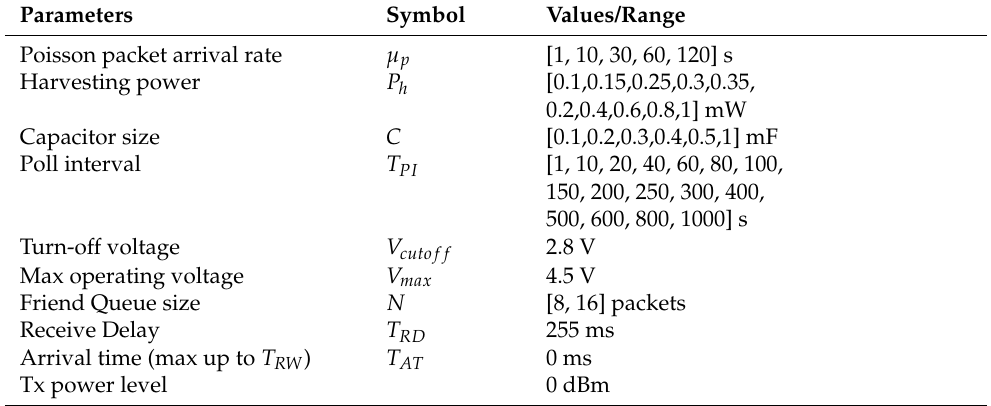
Table 2. Simulation